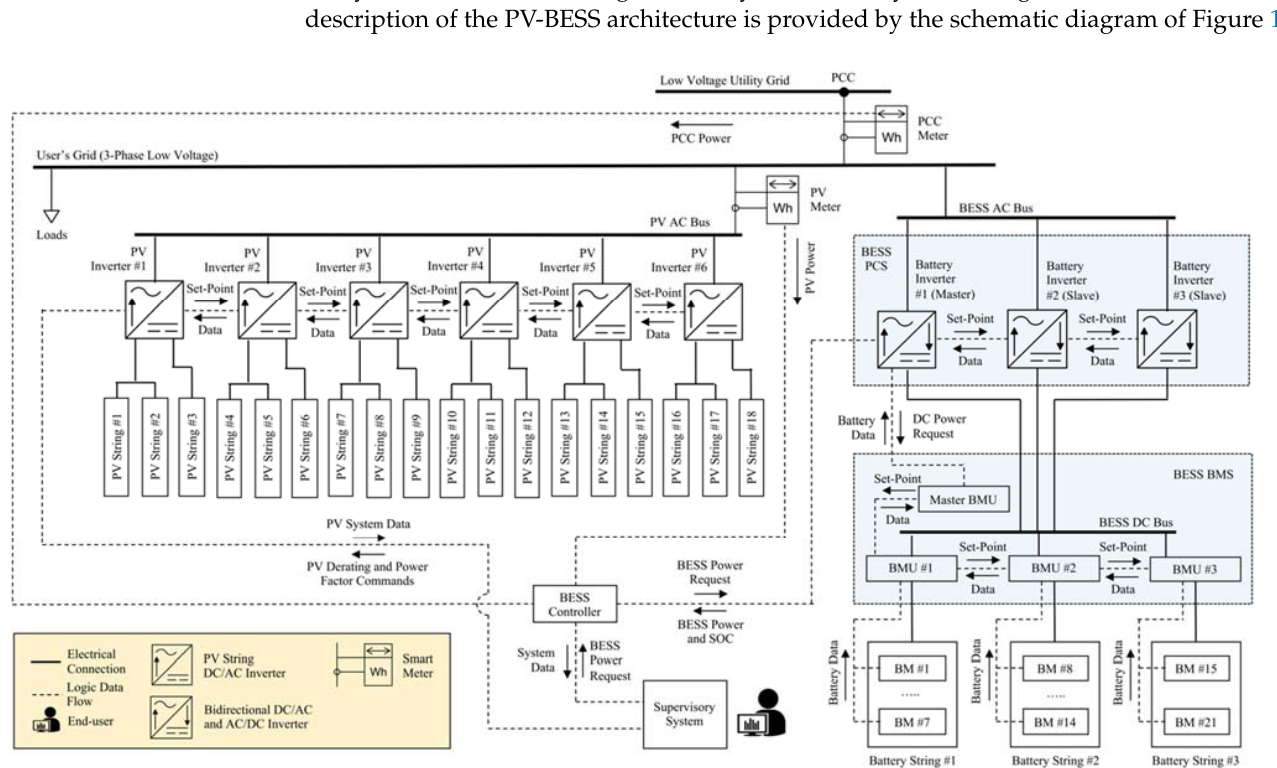
Figure 1. Schematic layout of the PV-BESS system architecture. PV: Photovoltaic, BESS: battery energy storage system, BMS: battery management system, BM: battery module, BMU: battery management unit, PCS: power conversion system, PCC: point of common coupling, AC: alternating current, DC: direct current, SOC: state of charge.